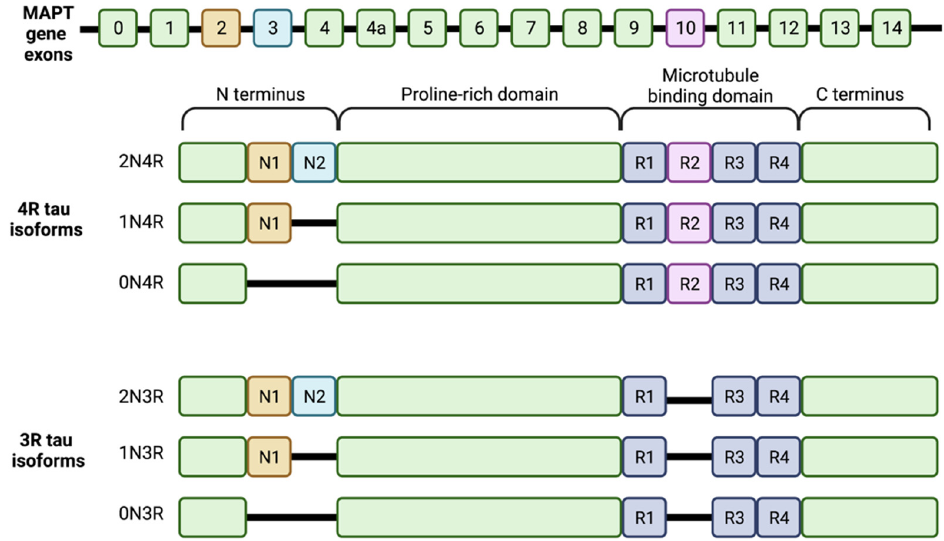
Figure 1. The six tau isoforms present in the human brain produced via alternative splicing of the MAPT gene’s 16 exons. Exons 2 and 3 encode the two possible N-terminal inserts N1 and N2 (shown in orange and blue). Exon 10 encodes the second microtubule binding repeat (R2, shown in pink) in the microtubule binding domain. Alternative splicing results in 6 isoforms that vary by the number of N-terminal inserts (0N, 1N or 2N) and the presence or absence of R2 (4R isoforms or 3R isoforms, respectively).